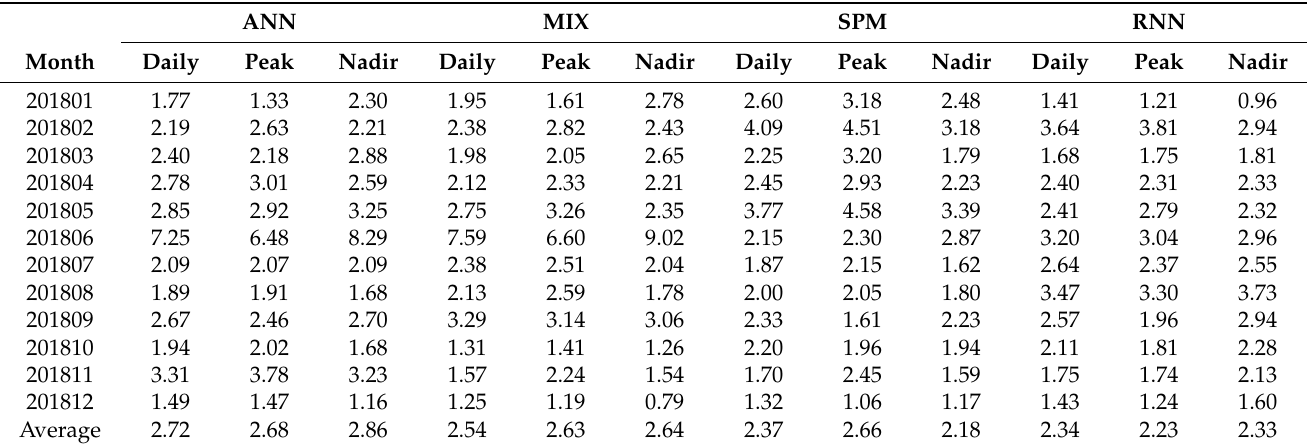
Table 5. Performance Comparisons of the Monthly MAPE (Daily Load Average, Peak Load and Nadir Load) for the ( D + 1)-day Forecasts with the Artificial Neural Network (ANN), mixed model (MIX), SPM and RNN Models.